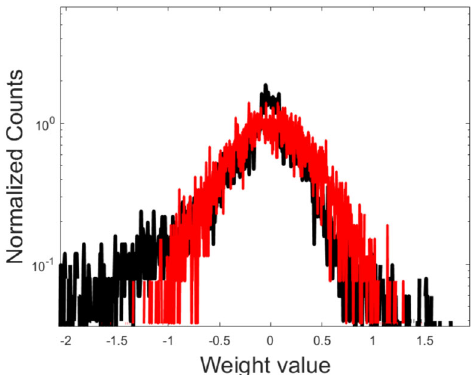
Fig. 4 The distribution of weights. Distribution of the weights of a perceptron. The red line follows the spectral training limited the N 1 + N 2 eigenvalues. The black line follows the training in direct space. Here, N 1 × N 2 parameters are adjusted in the space of the nodes. The distribution is very similar, but the spectral learning employs about 10% of the parameters used in direct space. The distributions obtained when forcing the training in direct space to operate on a subset of N 1 + N 2 weights are very different from the one displayed (for every choice of the randomly selected family of weights to be